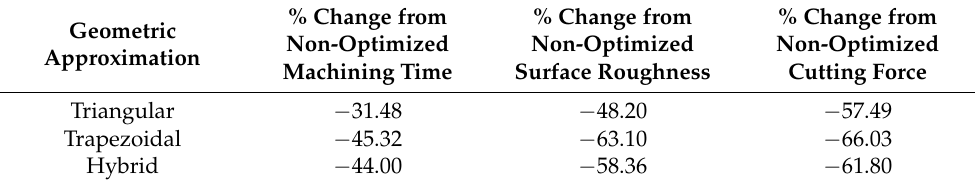
Table 3. Equal objective prioritization results.